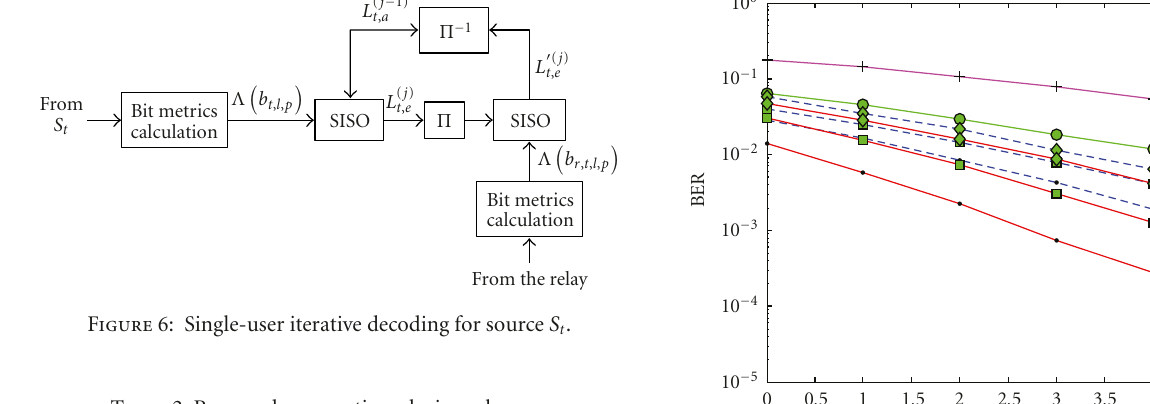
Table 2: Proposed cooperative relaying schemes. Scheme